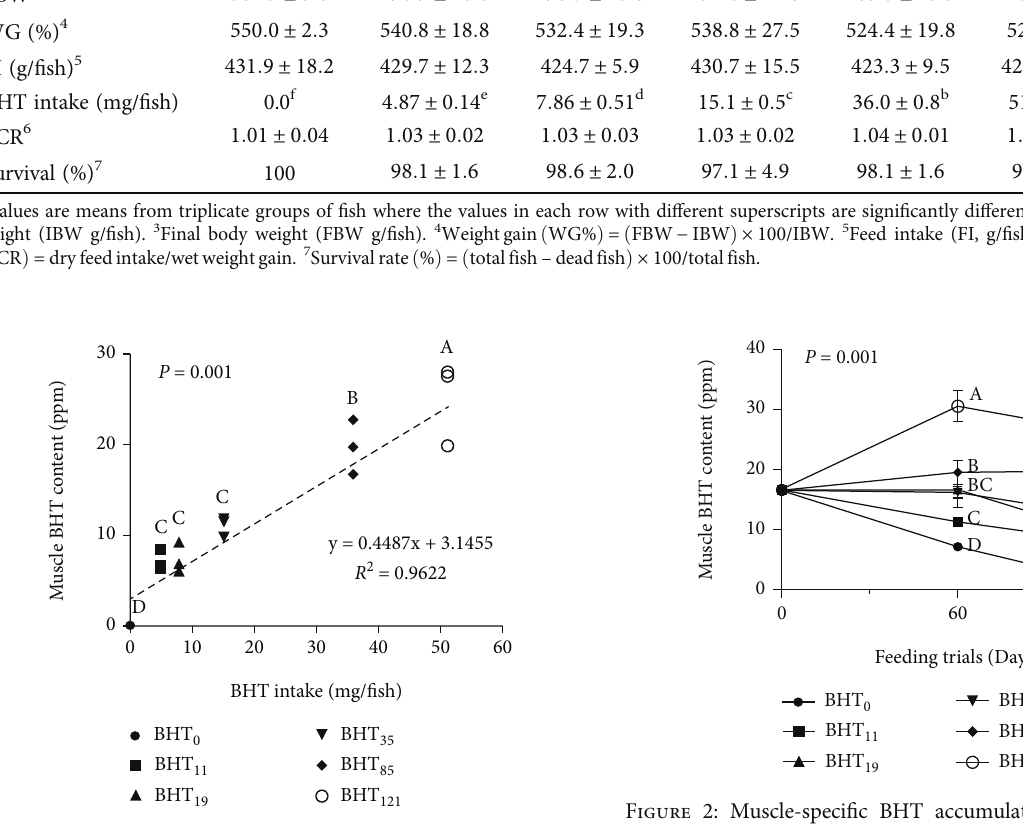
Figure 1: Muscle-speci fi c BHT content according to BHT intake over a 120-day growth trial in olive fl ounder ( Paralichthys olivaceus ). Values are means from triplicate groups of fi sh, and the values in each row with di ff erent superscripts are signi fi cantly di ff erent ( P < 0 : 05 ).